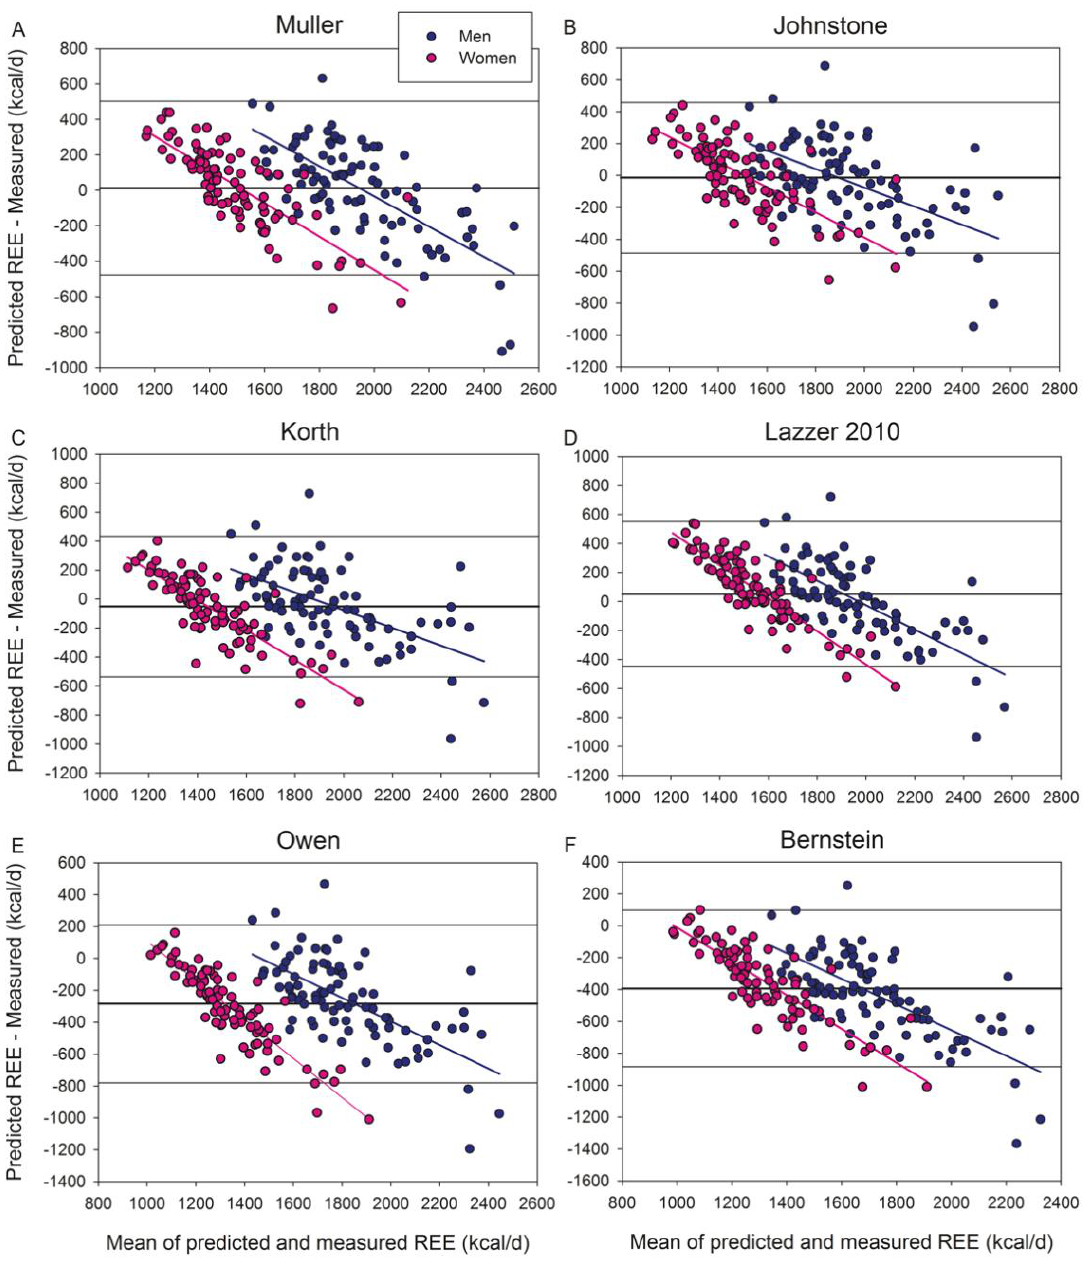
Figure 4. Bland–Altman plots displaying the agreement between measured and predicted REE by the body composition-based equations of ( A ) Muller, ( B ) Johnstone, ( C ) Korth, ( D ) Lazzer 2010, ( E ) Owen, and ( F ) Bernstein. All these equations included obese subjects in their populations. The thick continuous line indicates the mean value of the differences between predicted and measured REE (bias). The thin lines delimit the 95% confidence interval. All the regression lines were statistically significant at p < 0.001, indicating a systematic bias. Note that “Y” and “X” axes have different scales.